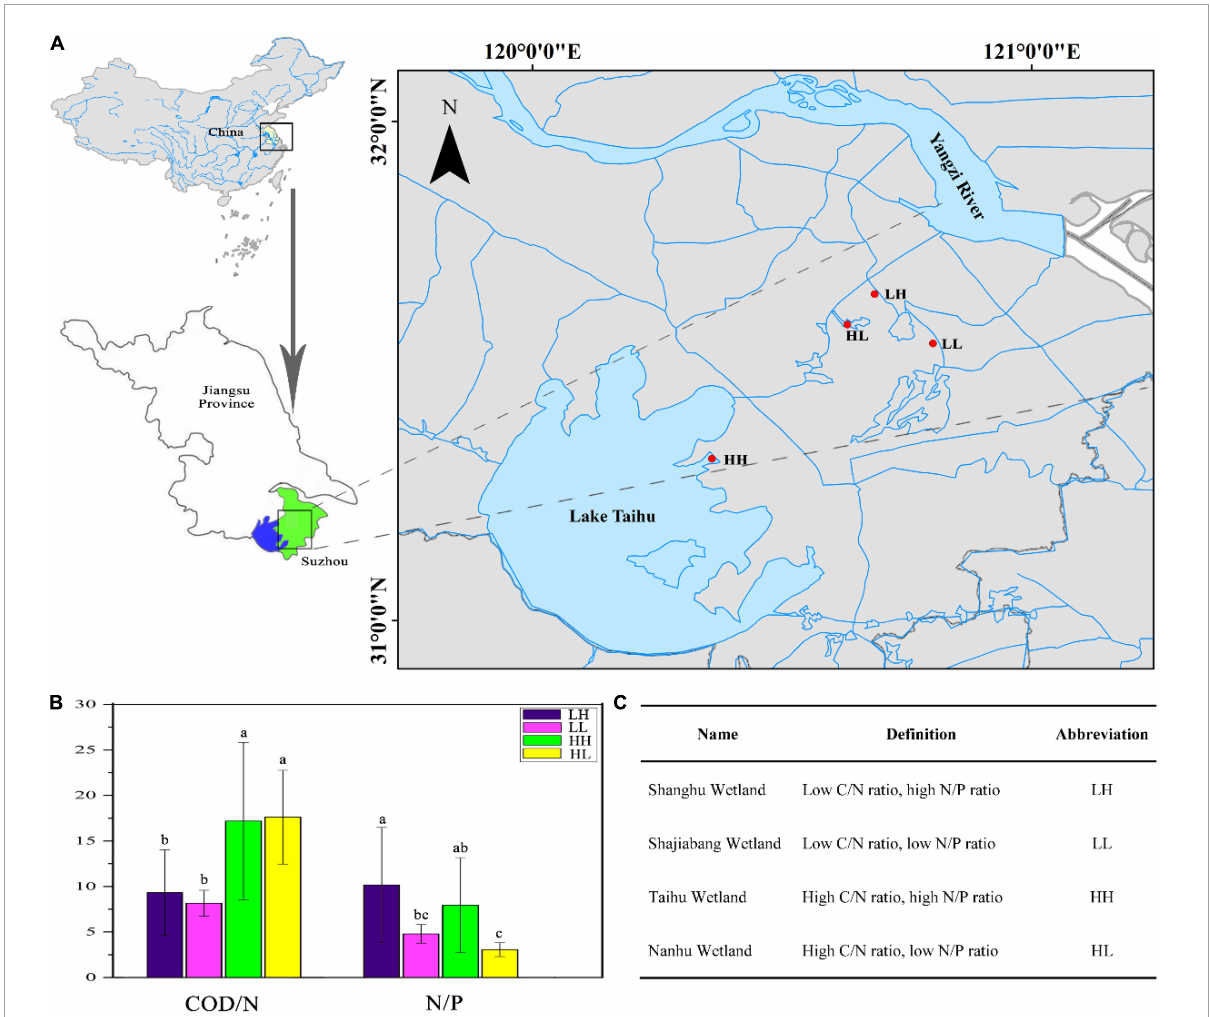
FIGURE1 (A) Sampling locations in the four wetlands. LH: Shanghu Wetland; LL: Shajiabang Wetland; HH: Taihu Wetland; and HL: Nanhu Wetland. (B,C) One-way analysis of variance (ANOVA) of Chemical oxygen demand to nitrogen (COD/N) and nitrogen to phosphorus (N/P) in the four wetlands. Different superscripted lowercase letters indicate p <